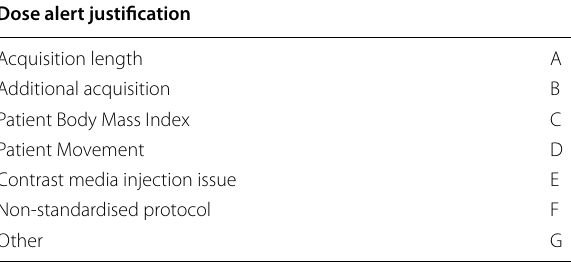
Table 2 List of dose alert